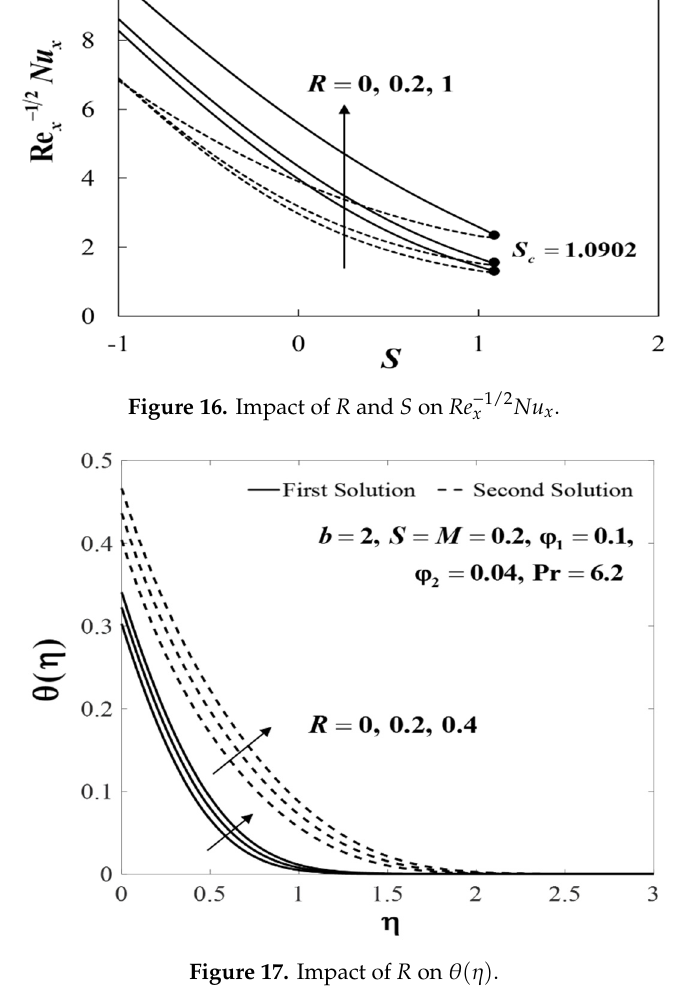
Figure 17. Impact of R on θ ( η ) .